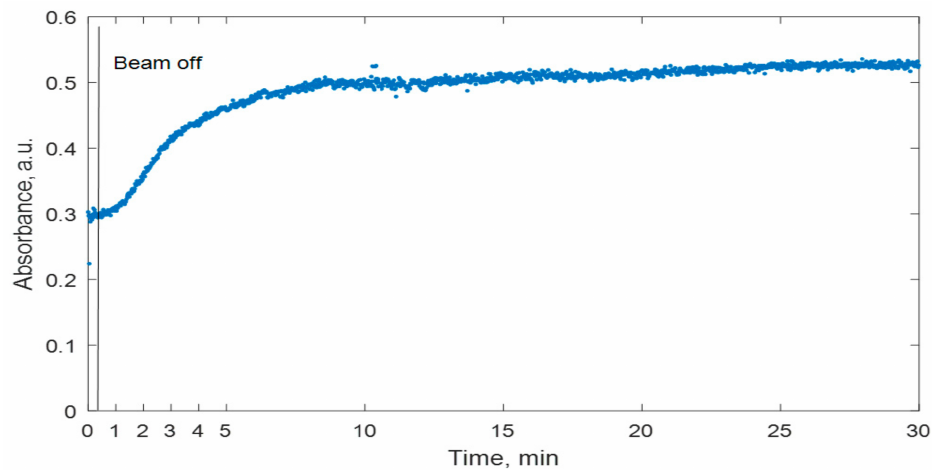
Figure 3. Variations of optical properties in irradiated nMAG dose gel over time period of 30 min.